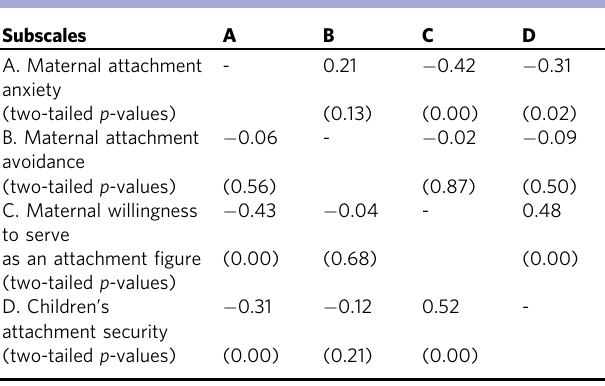
Table 2 Summary of Spearman rank correlation coef fi cients in Samples 1 and